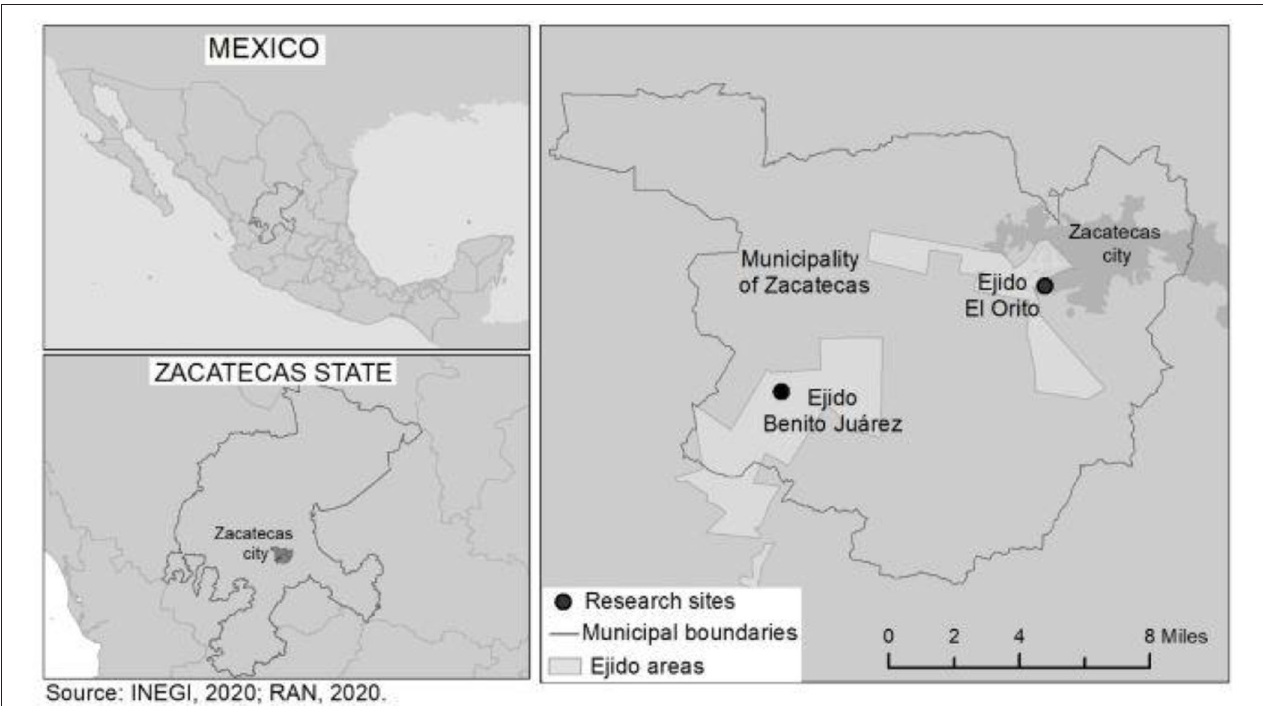
FIGURE 1 | Research